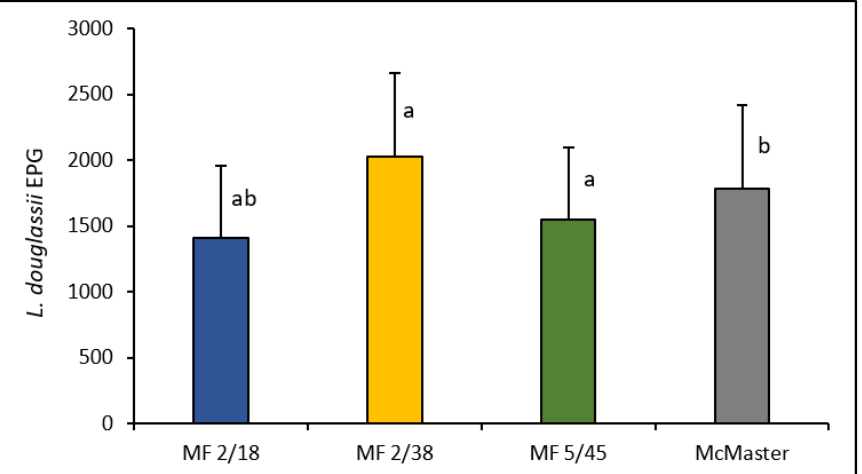
Figure 4. L. douglassii average EPG values and standard deviations in Mini-FLOTAC for small animals (MF 2/18), exotic animals (MF 2/38) and herbivores (MF 5/45) and McMaster. a: significant differences between MF protocols; b: significant difference between MF 2/18 and McMaster.